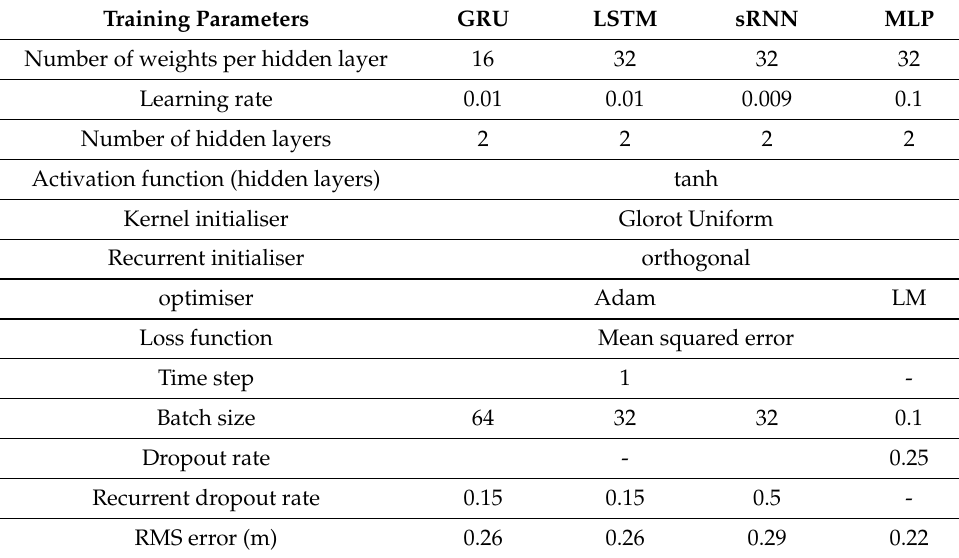
Table 3. Hyperparameters of the machine learning